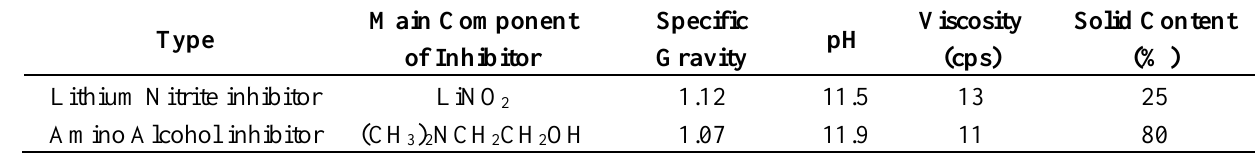
Table 1. Physical properties of inhibitors.